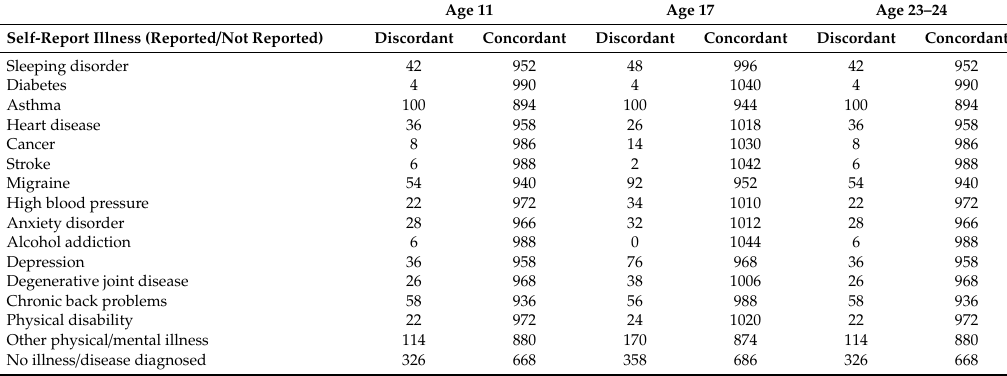
Table 3. Self-report of physical and mental illness (based on valid information for both twins only)